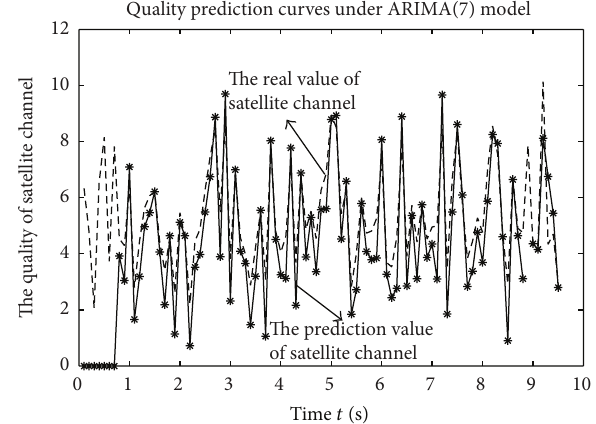
Figure 9: Comparison of channel quality sequence and data with smoothing